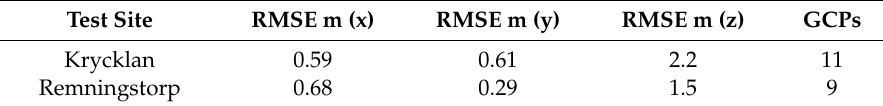
Table 5. Accuracy analysis after geometric correction using